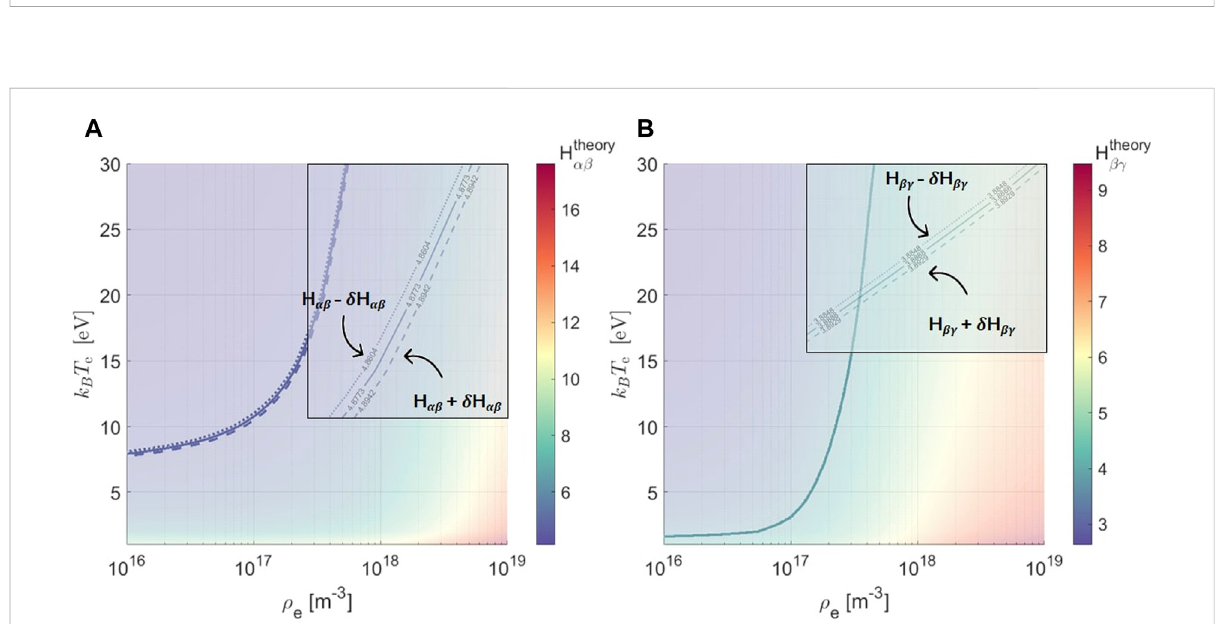
FIGURE 6 Surface-contour plot of experimental 〈 H αβ 〉 isoline (solid line) on top of theoretical H αβ isosurface (A) , and of experimental 〈 H βγ 〉 isoline (solid line) on top of theoretical H βγ isosurface (B) , from Yacora calculations, on the plane energy k B T e [eV] vs. electron density ρ e [m − 3 ]. Experimental uncertainties σ 〈 H αβ are shown as dashed (dotted) lines, better evinced in the insets. Both plots refer to the experimental run 3, at P RF = 350 , βγ 〉